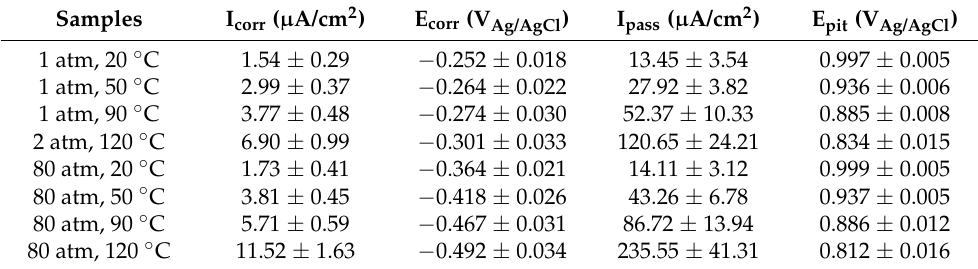
Table 1. Corrosion data determined from the potentio-dynamic polarization